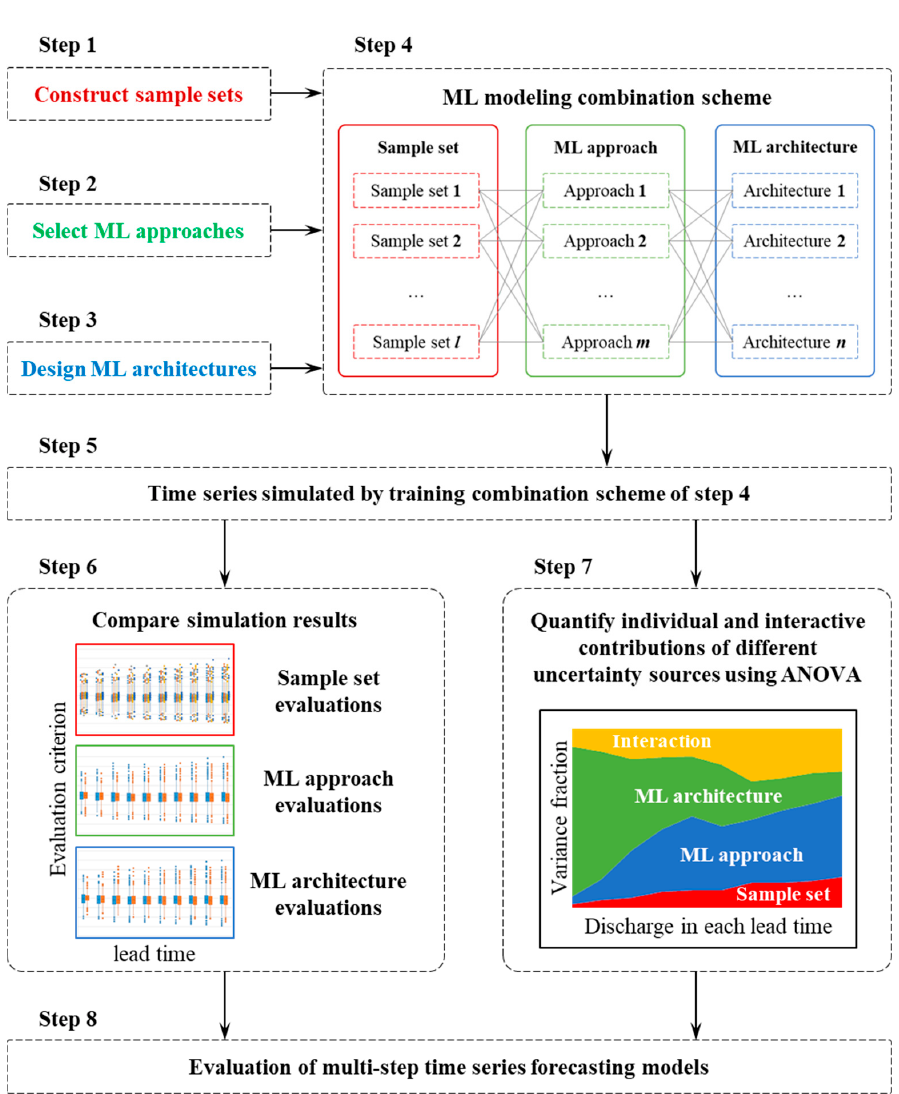
Figure 1. Diagrammatic flowchart of the proposed framework for uncertainty quantification in Machine Learning (ML) modeling for multi ‐ step time ‐ series forecasting.